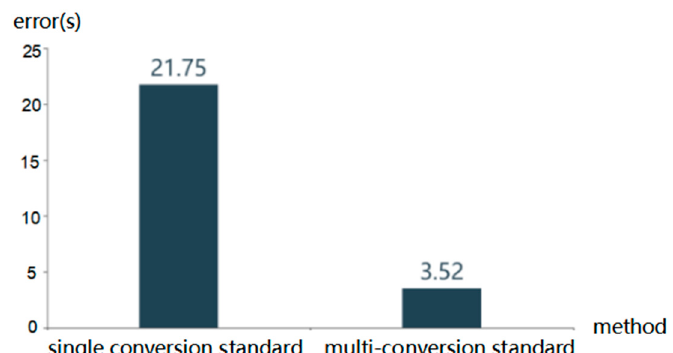
Figure 4. Average error in average delay of cars.